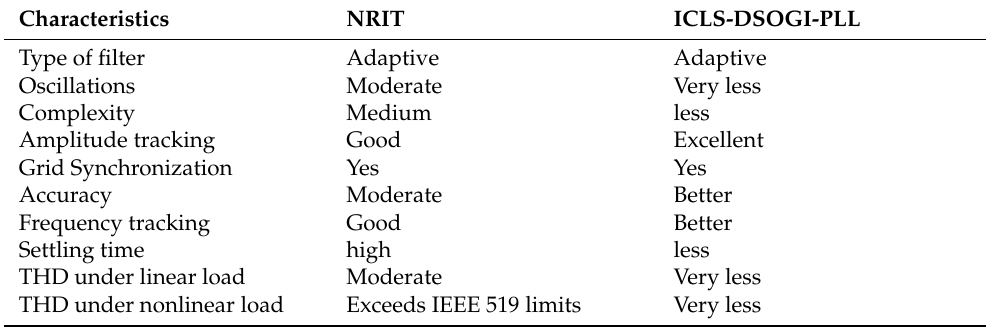
Table 7. Comparison table between the proposed inverter control and recent NRIT from the literature.